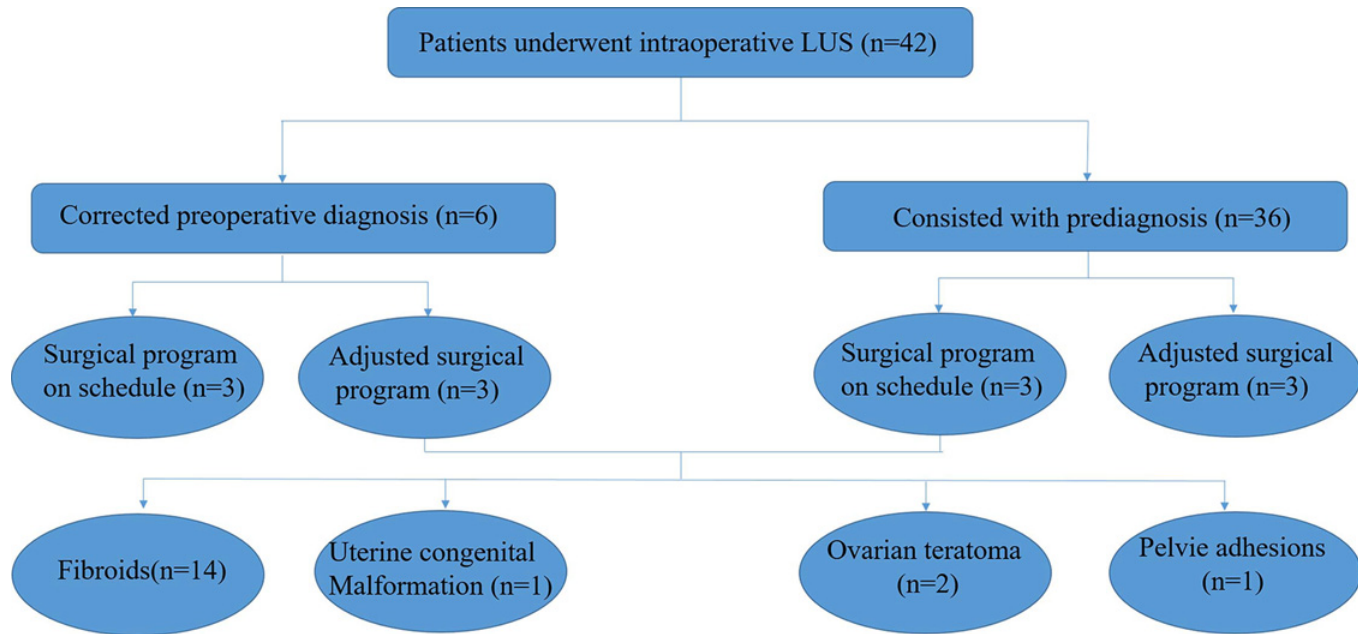
Fig 1. The flowchart of the study. The stages are as follows: laparoscopic ultrasound images provide the raw image of the uterus; detection of uterus border via an active contour model; outputting the outline of the detected uterus for laparoscopic diagnosis and surgical guidance and analysis (this may be used for detecting lesions on the uterus or determining the abnormality of the